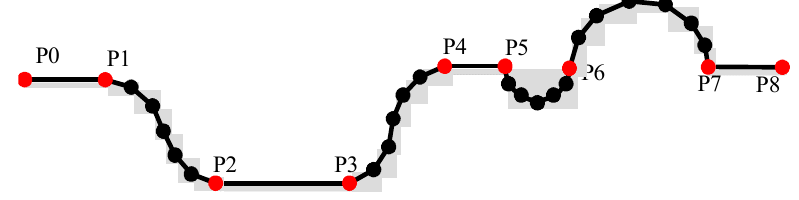
Figure 3. Constant speed interval planning of tool path.